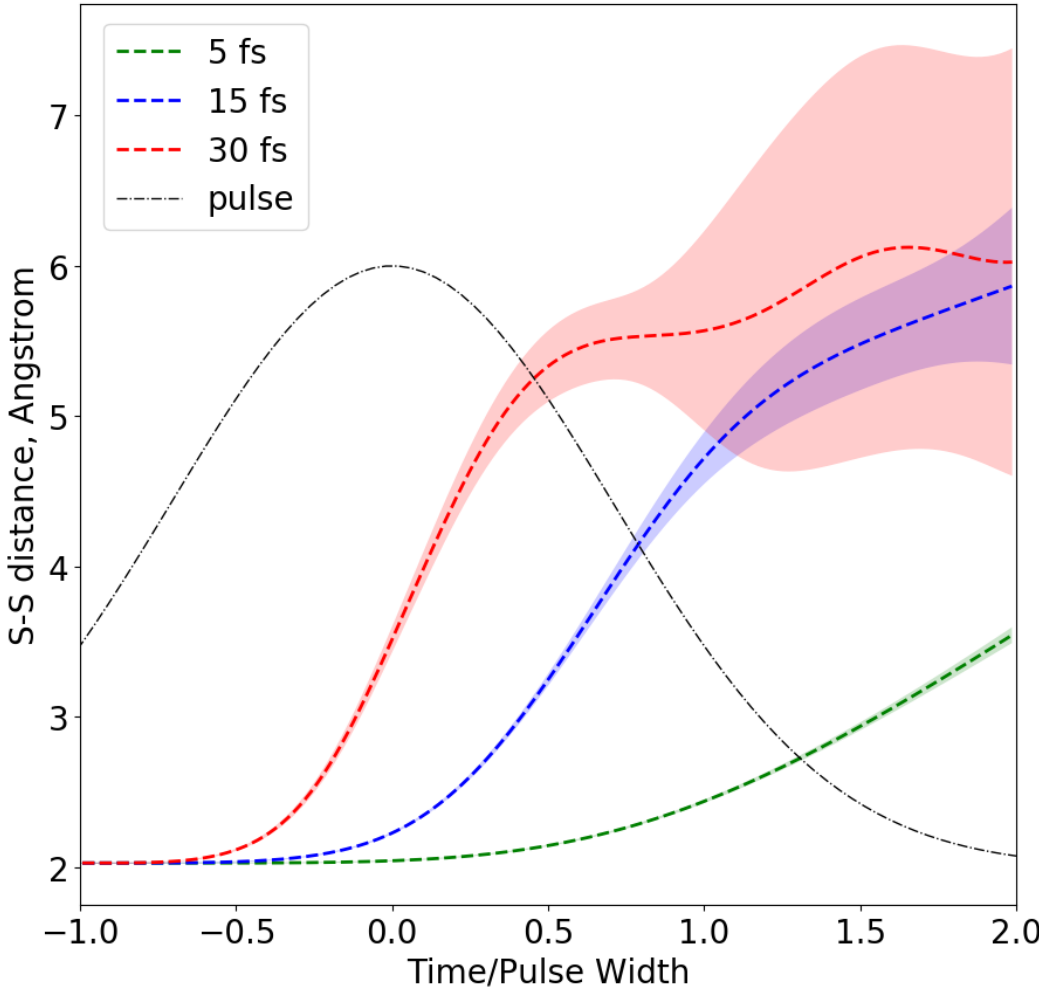
Figure 1. Average distance between sulfur atoms in 30 disulfide bonds found in a single unit cell of a lysozyme crystal. Colours denote the average distance (dashed lines) and regions within one standard deviation from the average. An incident XFEL pulses with FWHM of 5 fs (green), 15 fs (blue), and 30 fs (red). Black line indicates a pulse